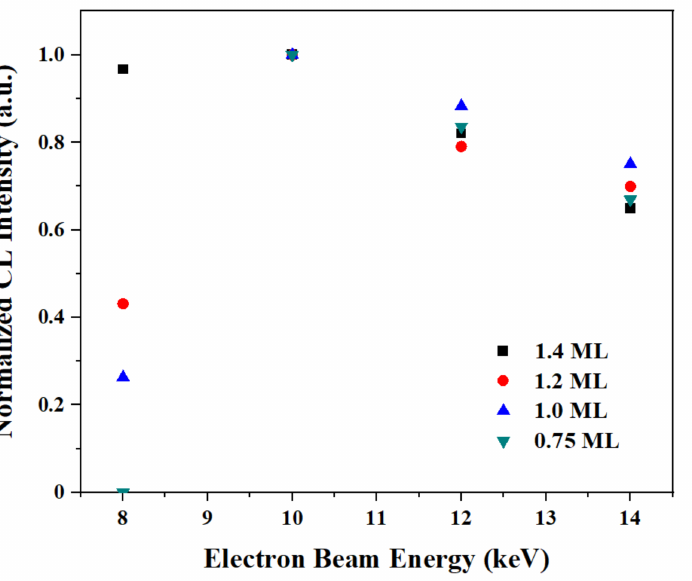
Figure 3. Normalized peak intensities of different InAs layers extracted from corresponding CL spectra excited with different beam energy. To indicate the relative trend, the highest intensities have been normalized to